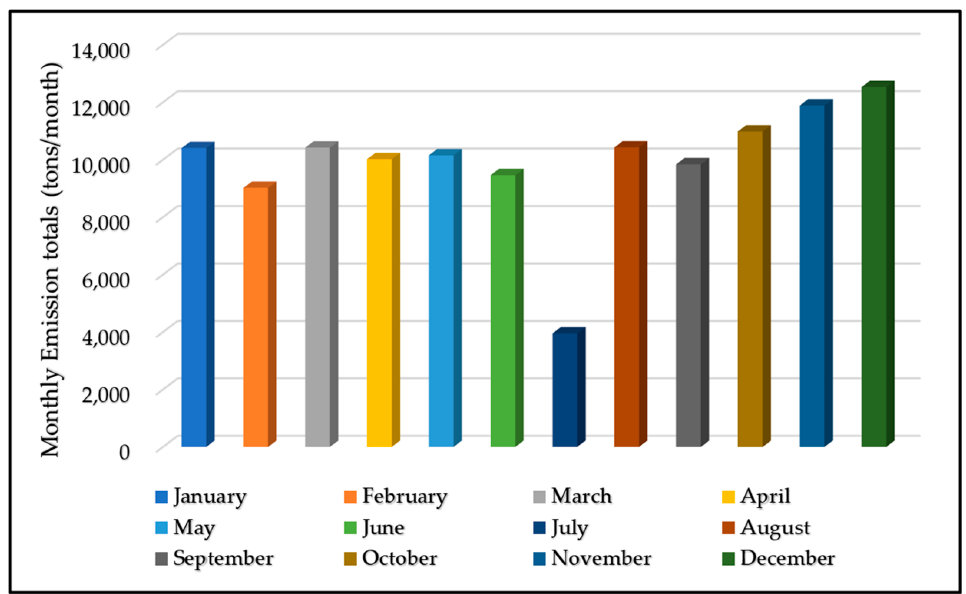
Figure 4. Monthly emissions patterns.